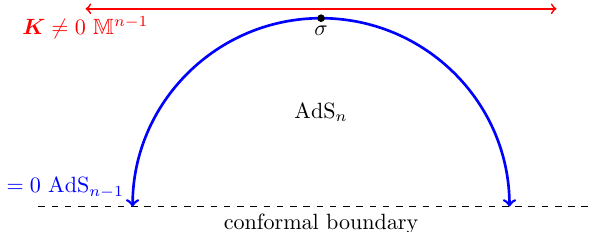
Figure 18 . Cartoonish representation of a totally geodesic AdS AdS n in the upper half space representation with metric (A.8). Choose a point (cid:27) consider all the geodesics beginning at (cid:27) with spacelike initial velocity tangential to AdS n locus of all these geodesics is a submanifold of the totally geodesic AdS n curve. A physical deformation (motion slower than the speed of light) of AdS n take an in(cid:12)nite amount of time because the asymptotic parts of both manifolds are in(cid:12)nitely far apart. The distances between the corresponding arrowheads in M n (cid:0) 1 and in AdS n LMS This article